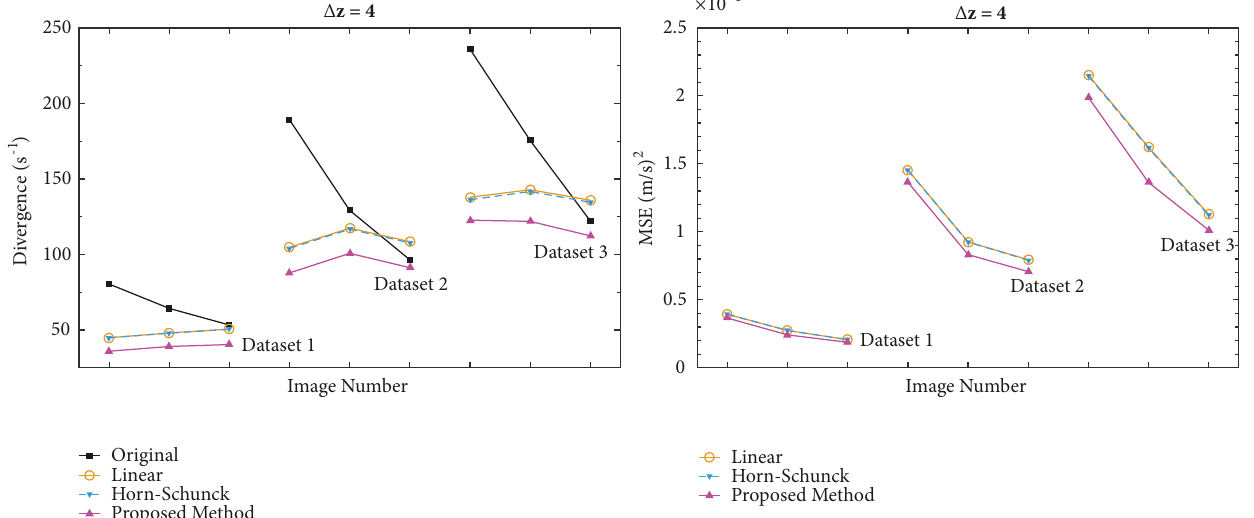
Figure 6: Divergence and MSE comparisons when slice distance is